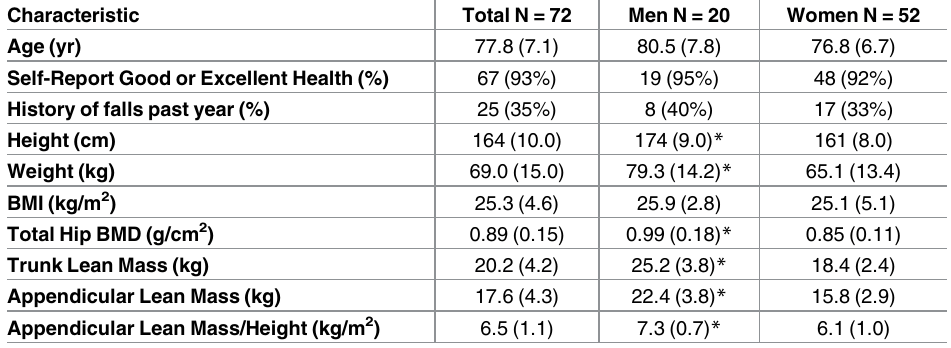
Table 1. Study participant characteristics.